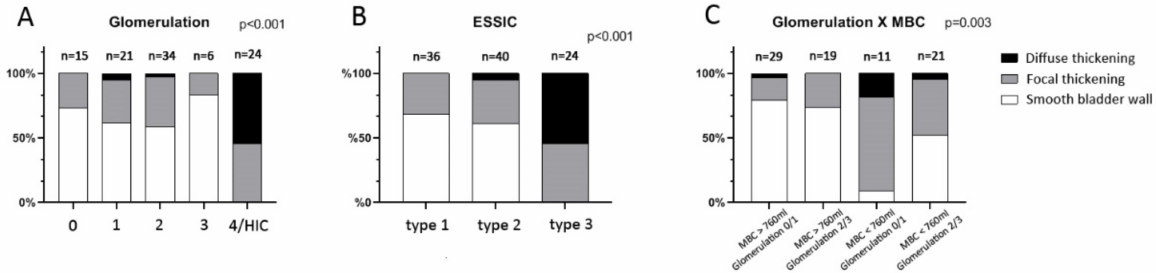
Figure 3. Association between various interstitial cystitis/bladder pain syndrome classification and bladder wall thickening on computed tomography: ( A ) subgrouping according to grade of glomerulation hemorrhage; ( B ) subgrouping according to ESSIC cystoscopy classification; ( C ) subgrouping according to combination of MBC and grade of glomerulation.